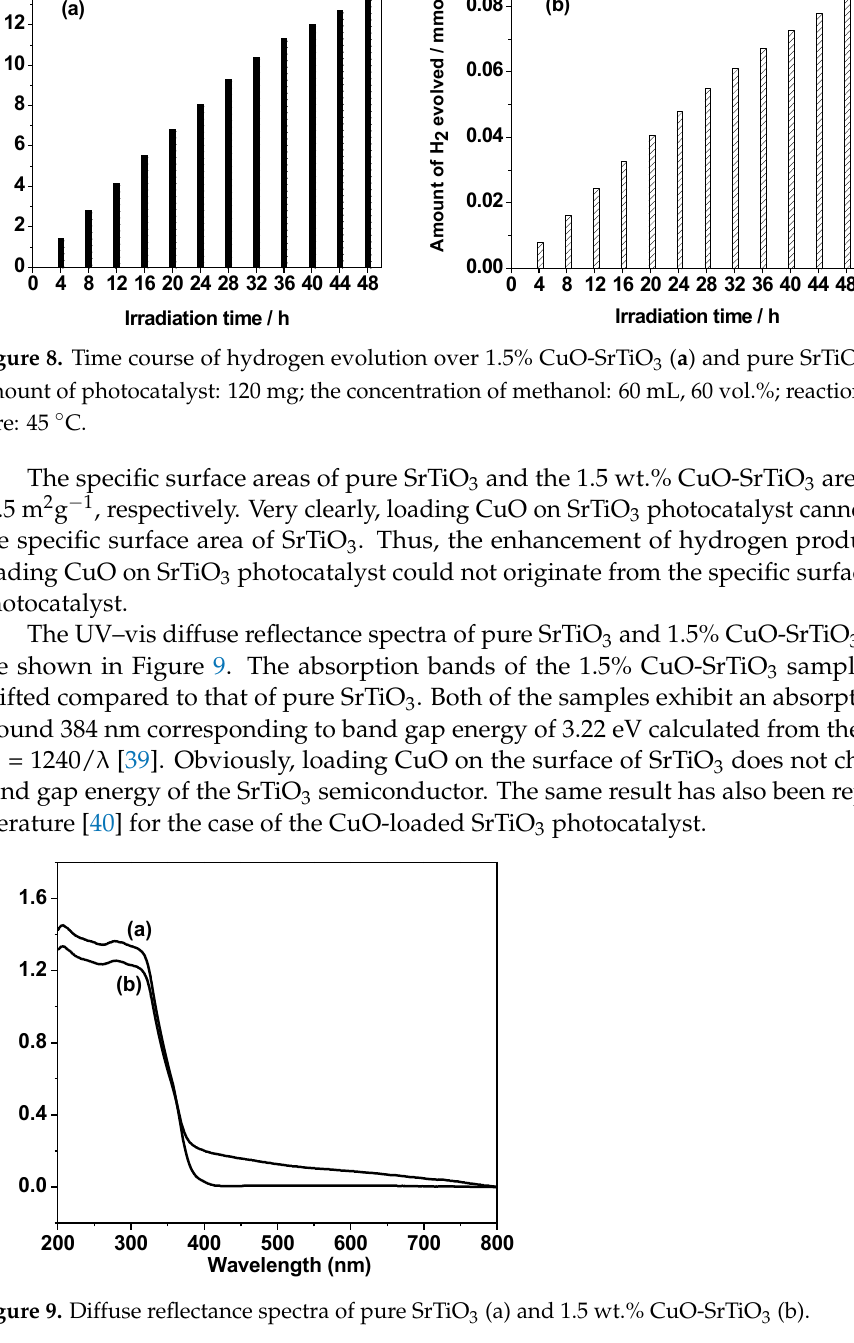
Figure 9. Diffuse reflectance spectra of pure SrTiO 3 ( a ) and 1.5 wt.% CuO ‐ SrTiO 3 ( b ).